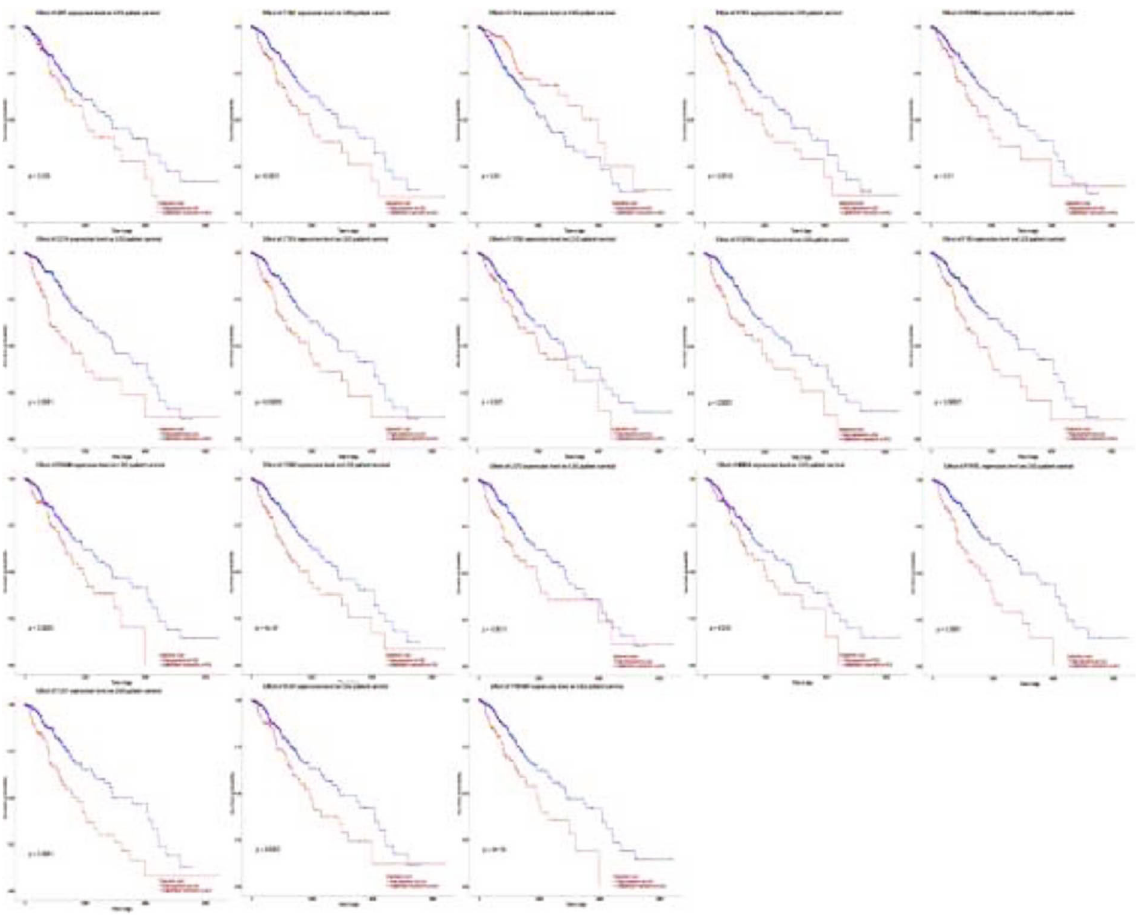
Figure 4: The prognostic information of 22 selected DEGs was obtained by UALCAN tools analysis. 18 of the 22 DEGs were signi fi cantly associated with a poor survival rate ( P < 0 : 05